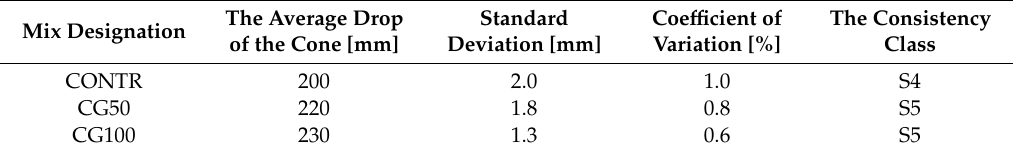
Table 4. The consistency of cementitious composite mixes.